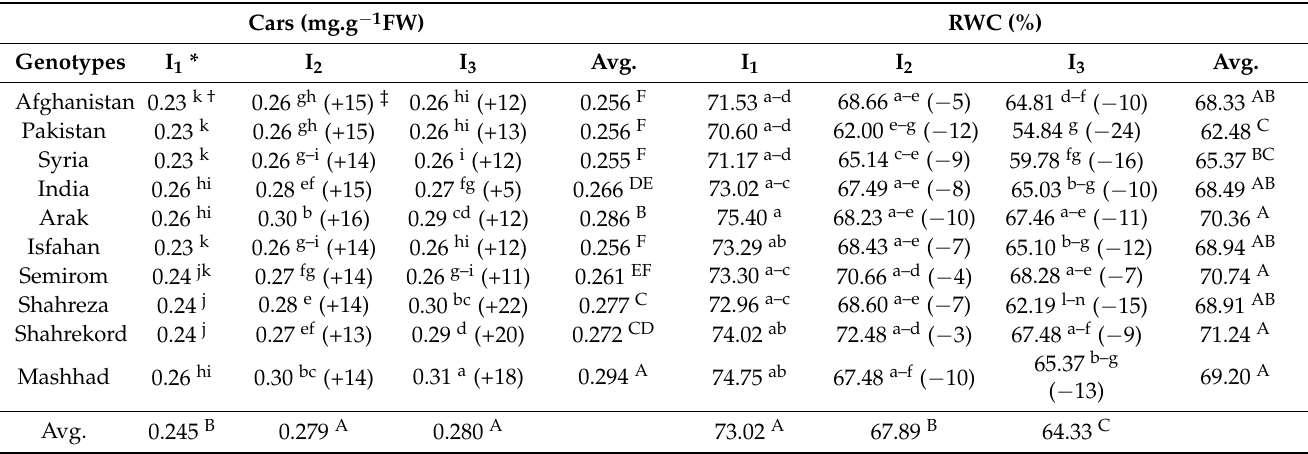
Table 2. Mean comparison of the effect of irrigation regime (I), genotype (G), and their interaction on Cars and RWC of black